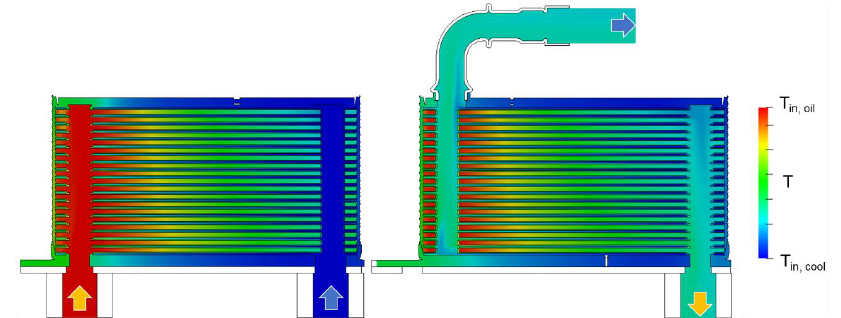
Figure 19. Cooler B: Temperature distribution across two planes passing through inlet and outlet ducts. Operating conditions: Q oil = 50%, Q cool = 80%.